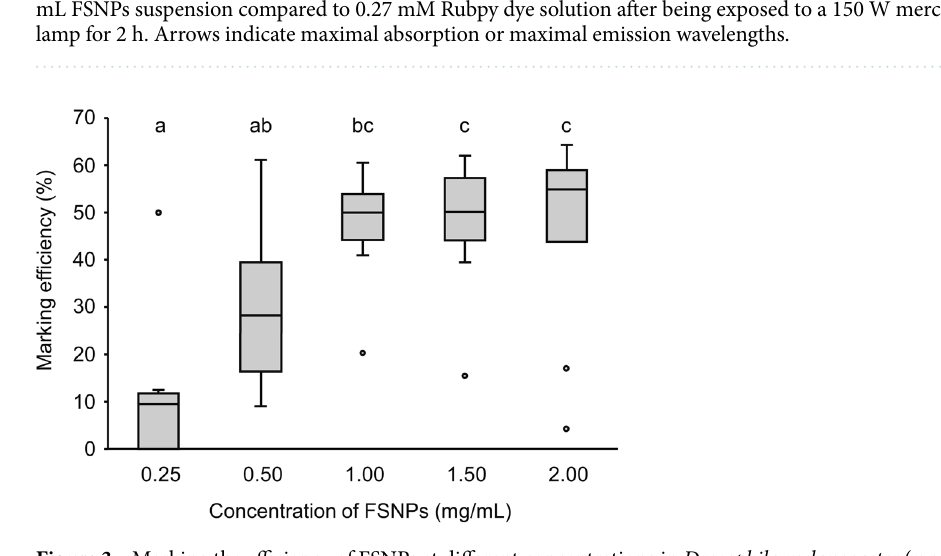
Figure 3. Marking the efficiency of FSNPs at different concentrations in Drosophila melanogaster ( n of each treatment = 10, males and females combined). The horizontal lines within each box indicate the median, the box edges indicate the 75th and 25th percentiles, the whiskers show the maximum and minimum, and the circles represent outliers. Treatments with a common letter are not significantly different from each other as revealed by the aligned rank test at the 5% level of